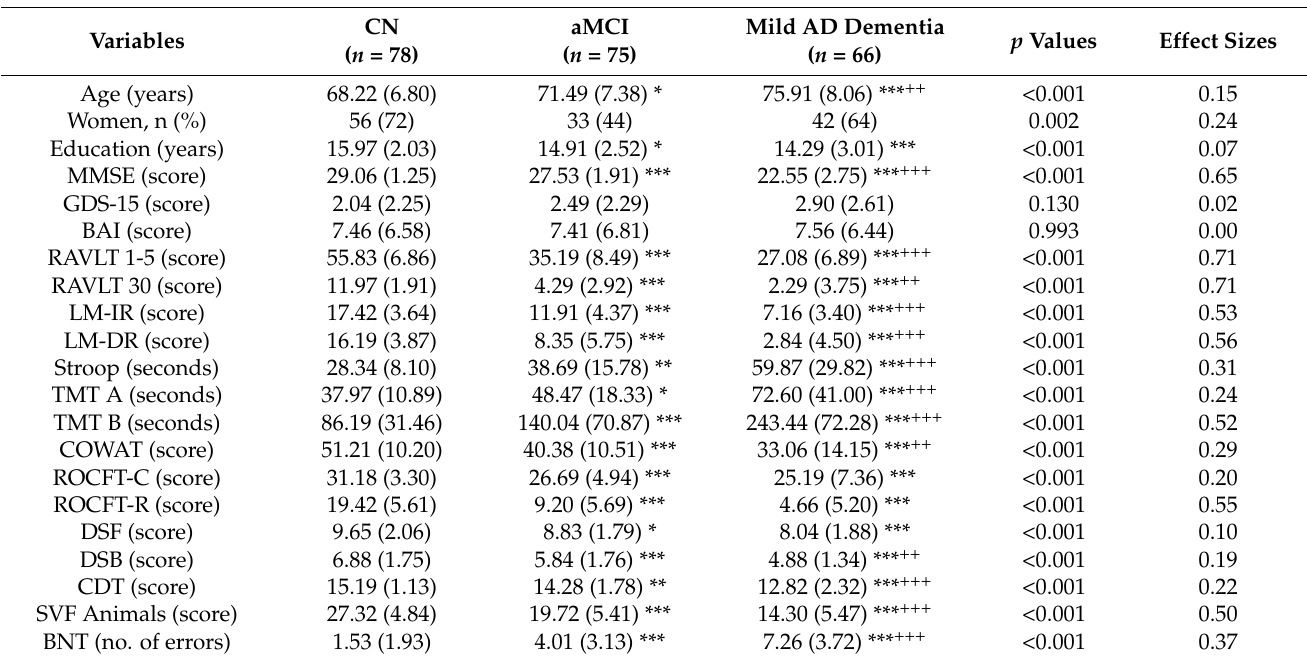
Table 1. Characteristics of study